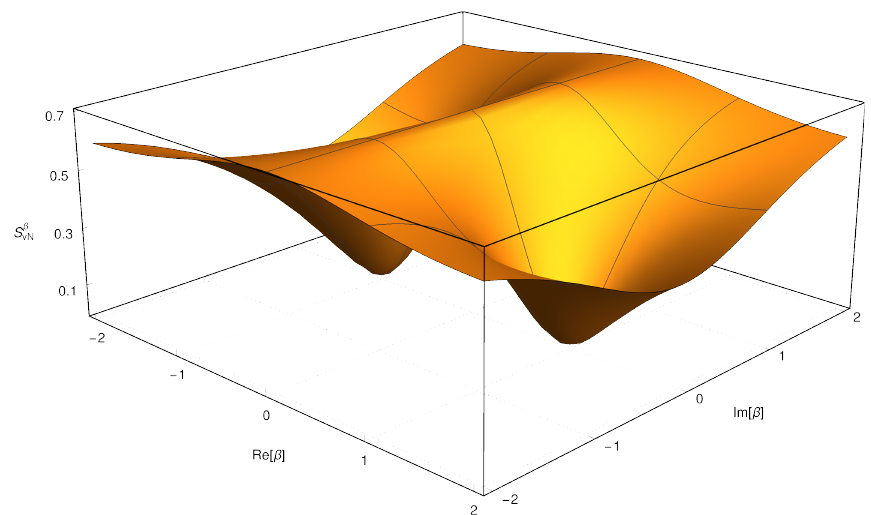
Figure 5: In above, the typical behavior of von Neumann entropy with respect to pa- rameter β is plotted for a subsystem of length (cid:96) starting from boundary of the chain. Size of the full system is L = 30 and subsystem is l = 14. Rest of the parameters are: = 1, b = 1 and b = J = γ = 1, h = 1 , b 1, L , z 2 L , x , y 1, x , y